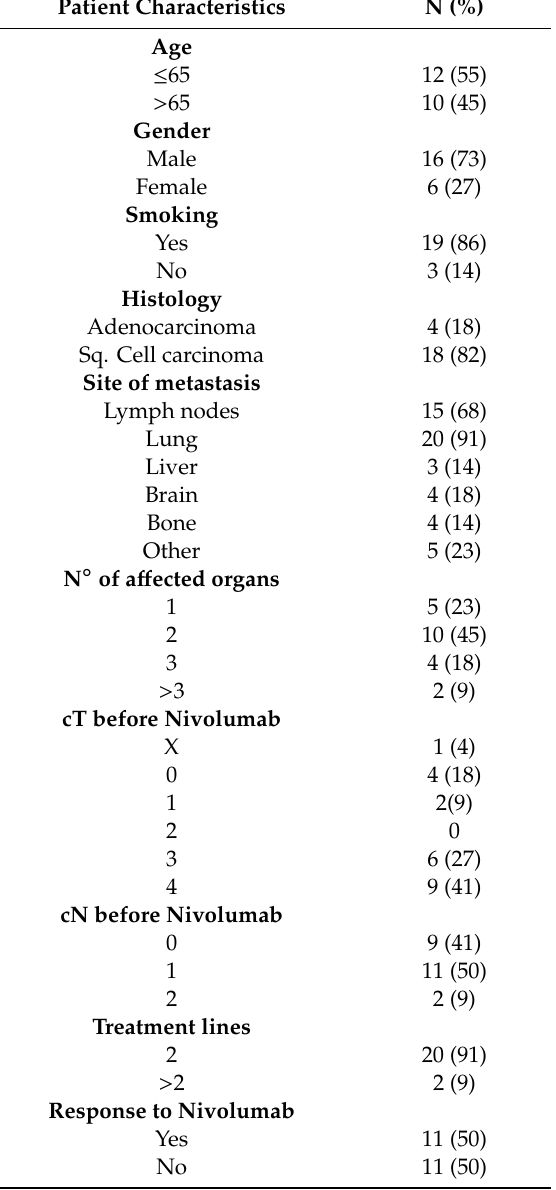
Table 1. Clinical feature of NSCLC